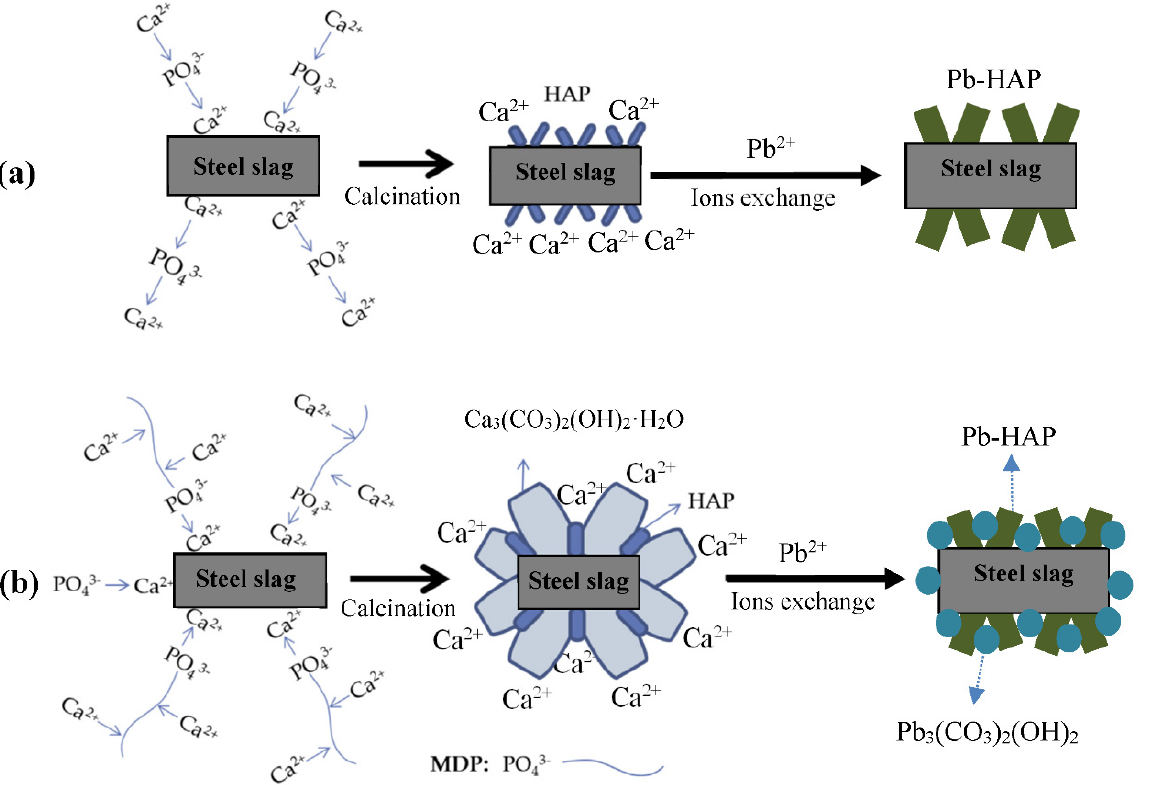
Figure 9. TEM and HRTEM images of S3 before ( a , b ) and after ( c – e ) adsorption of Pb 2+ .